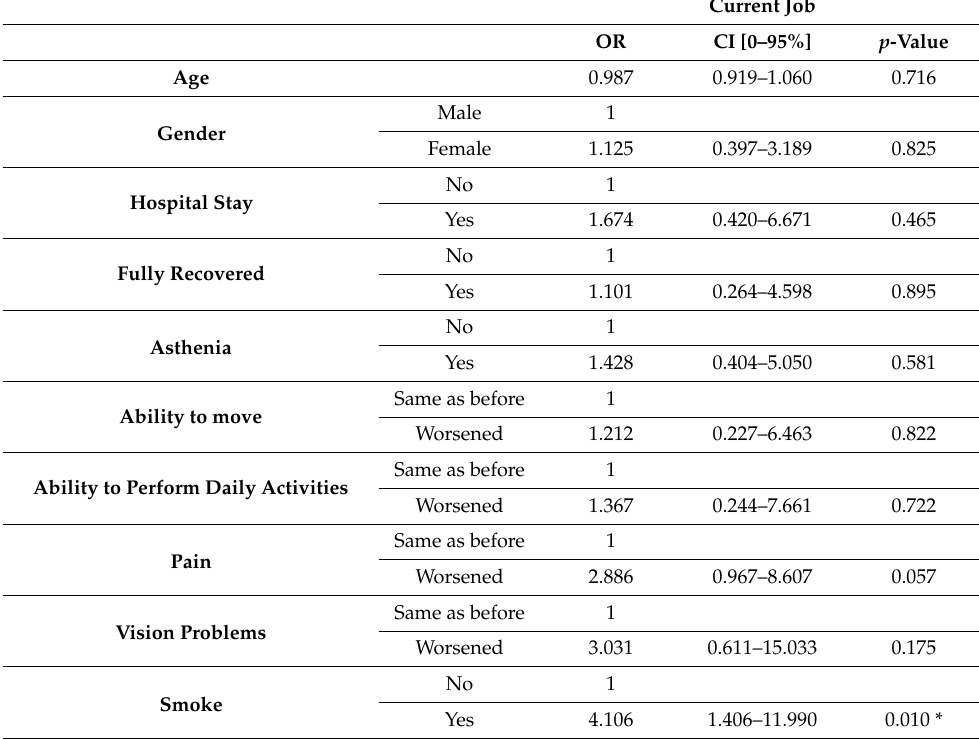
Table 5. Logistic regression analysis for current employment (* p ≤